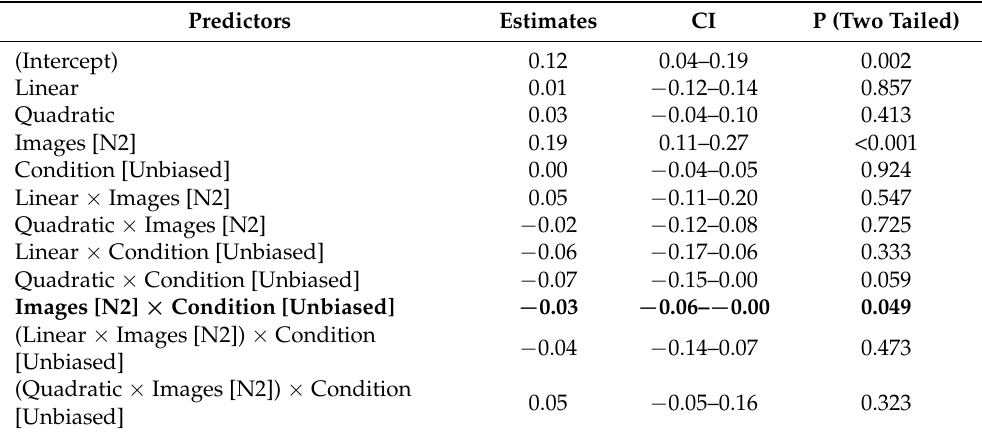
Table 6. Results of GCA analysis of AMC data for time window 4 (processing N2 relative to